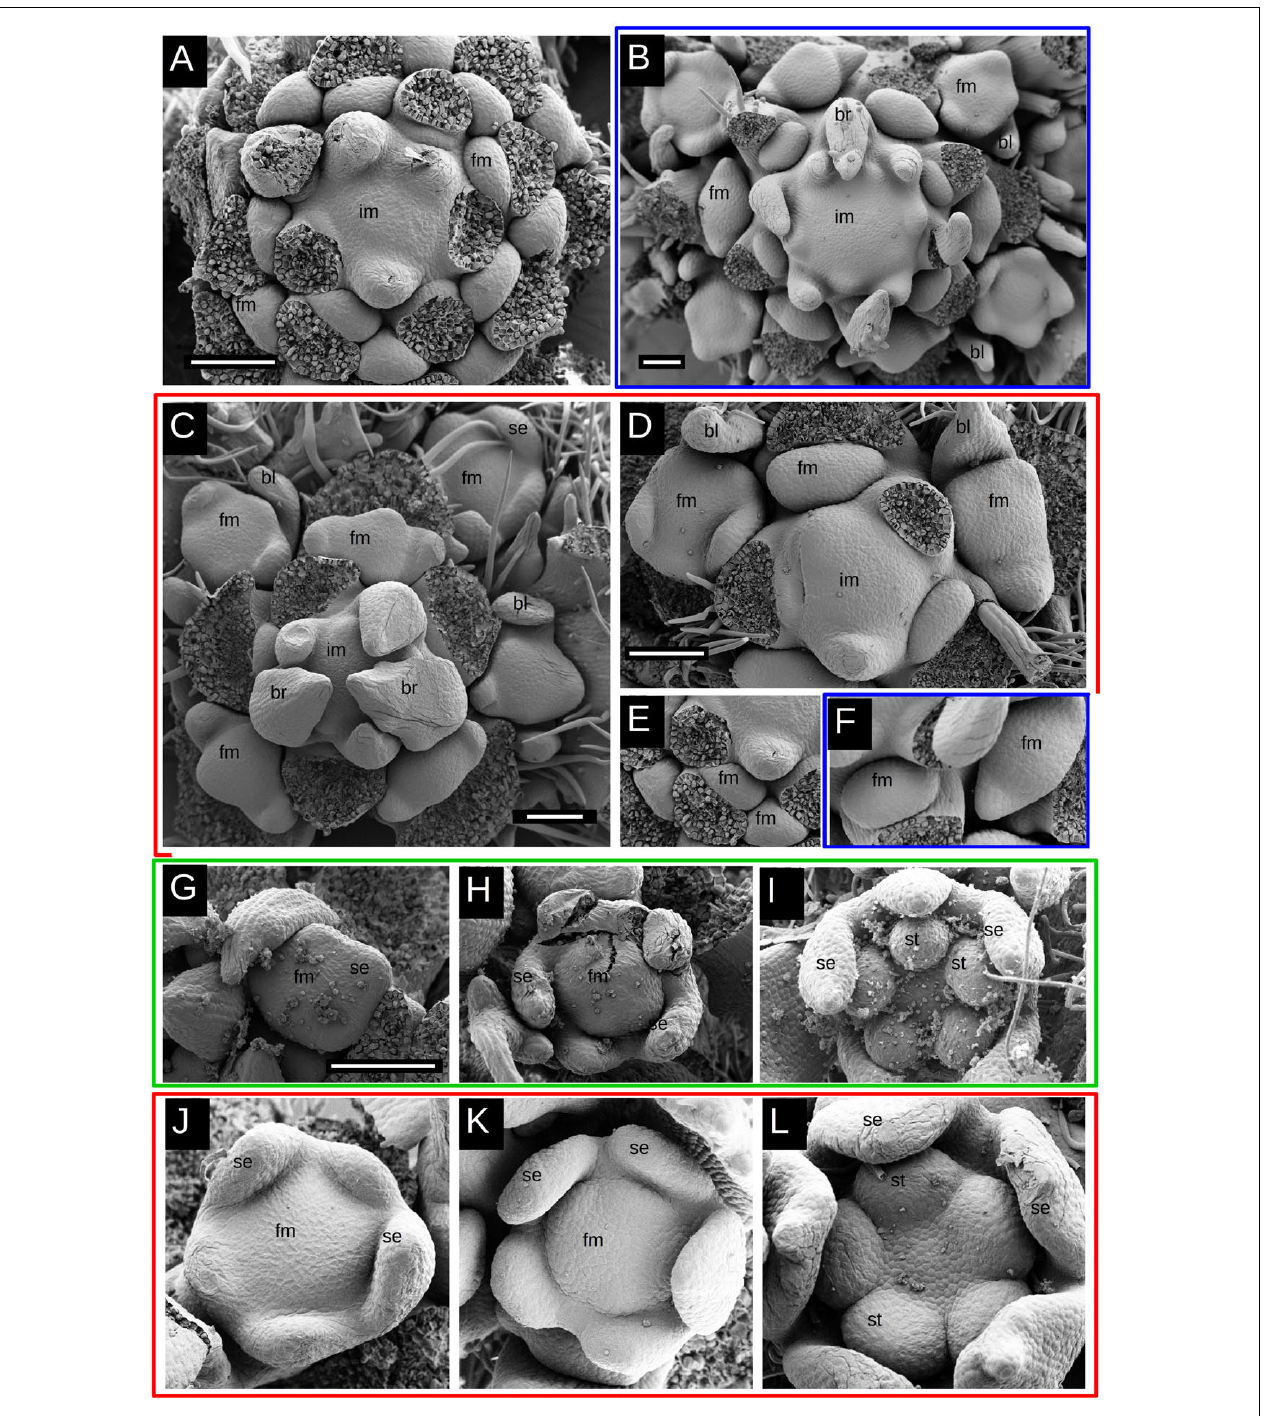
FIGURE 8 | Scanning electron micrographs of flower and inflorescence buds in Malesherbia. Red frame surround Radiate species, green frame the minute species and blue frames surround Tubular species. Glomerulate species without a frame. (A–F) Inflorescences, (G–I) Malesherbia humilis (Minute), (J–K) Radiate species. (A) Developing inflorescence of M. fasciculata (Glomerulate). Here, the inflorescence meristem is not particularly more expanded than the other species, nor any particularly higher phyllotaxis is manifest at floral bud initiation, thus there is no evidence for a FUM. (B) M. tocopillana , (C) M. deserticola , (D) M. linearifolia . (E) M. fasciculata; note the smaller size than (D) (same magnification D,E ). (F) M. tocopillana; note larger bud size than M. fasciculata in panel (E) (same magnification E,F ). (G) Stage I of M. humilis . (H) Same species in stage II. (I) Stage III of M. humilis . (J) Stage I of Radiate M. rugosa. (K) Stage II in Radiate M. paniculata . (L) Stage III of M. rugosa. Note the overall smaller bud size of M. humilis (G–I) compared to the equivalent stage of Radiate species (J–L) , same magnification (G–L) . All bars = 100 µ m. im = inflorescence meristem, fm = flower meristem, se = sepal, st = stamen, br = subtending bract, bl = bracteole.